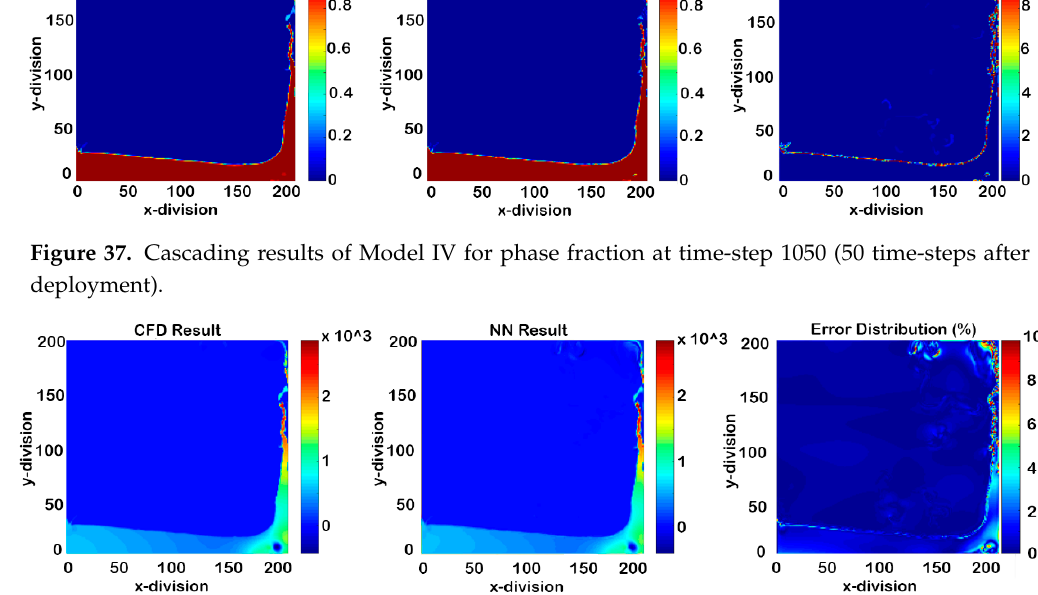
Figure 38. Cascading results of Model Ⅳ for pressure at time-step 1050 (50 time-steps after deployment).